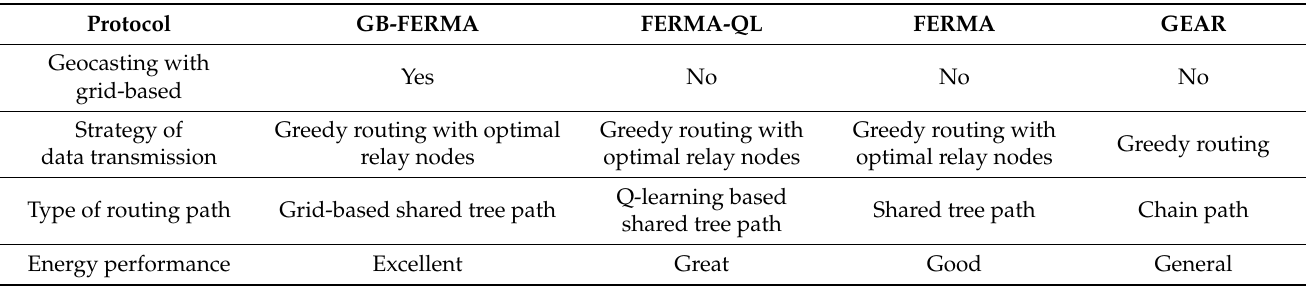
Table 1. The comparisons of GB-FERMA, FERMA-QL, FERMA, and